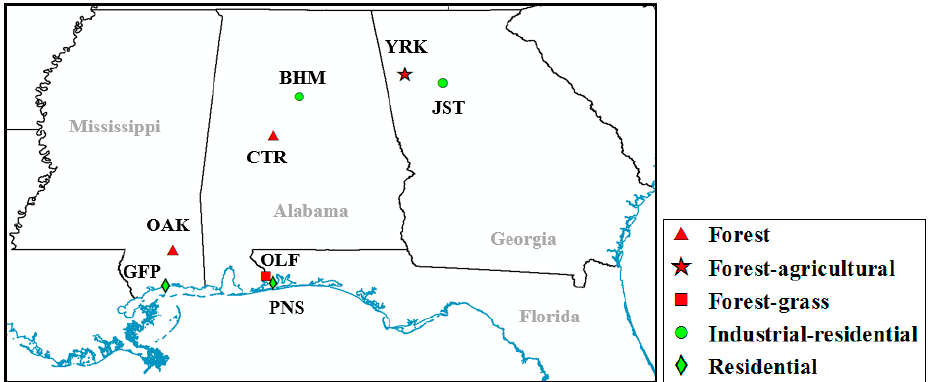
Figure 1. The geographical locations of the eight monitoring sites under the SEARCH (Green label indicates urban sites; red label indicates rural or suburban sites).